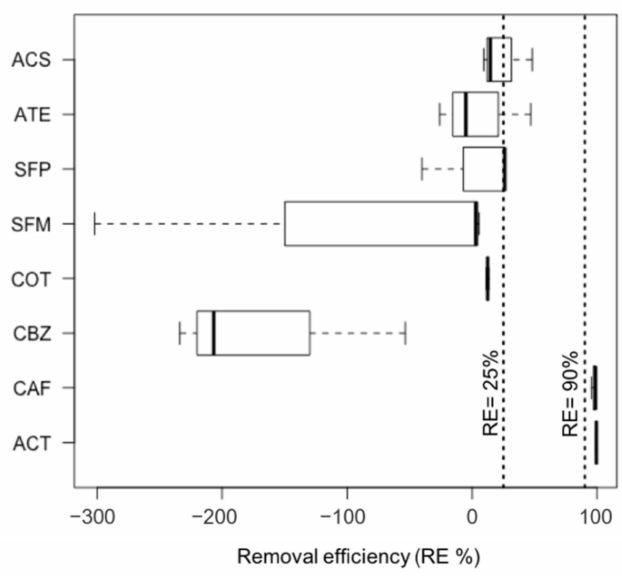
Figure 2. Removal efficiency of the eight target OWCs in the Hikkaduwa STP. - CAF indicates the magnitude of graywater loading at each sampling site. - ACT indicates the impact of untreated human excretion over short distances. - ACS indicates the general impact of domestic wastewater (both black and gray) on surface water. - CBZ indicates the presence of hospital residues over long distances. Table 3. Indicator criteria. Note: persistency (Y: RE > 90%; N: RE < 25%); potential pathway (B: black water, G: graywater).